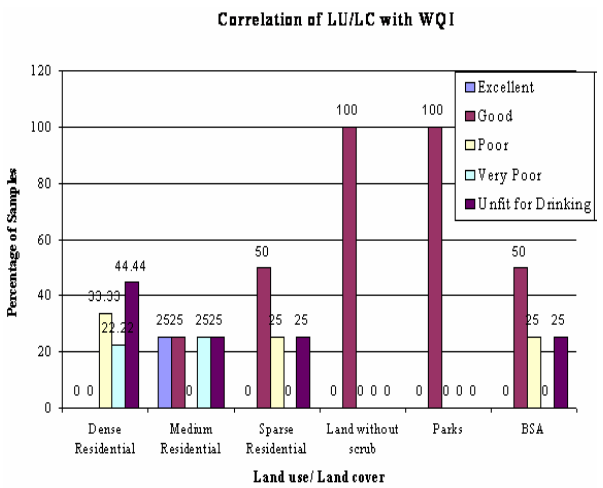
Figure 8 : Correlation of land use /land cover with water